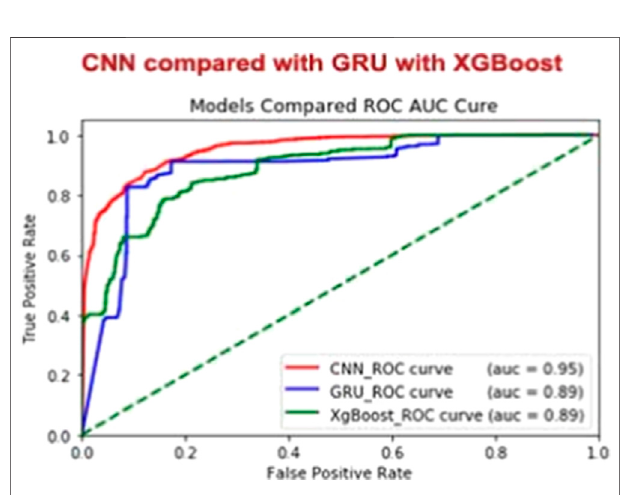
FIGURE 4 | Comparison of CNN with GRU and